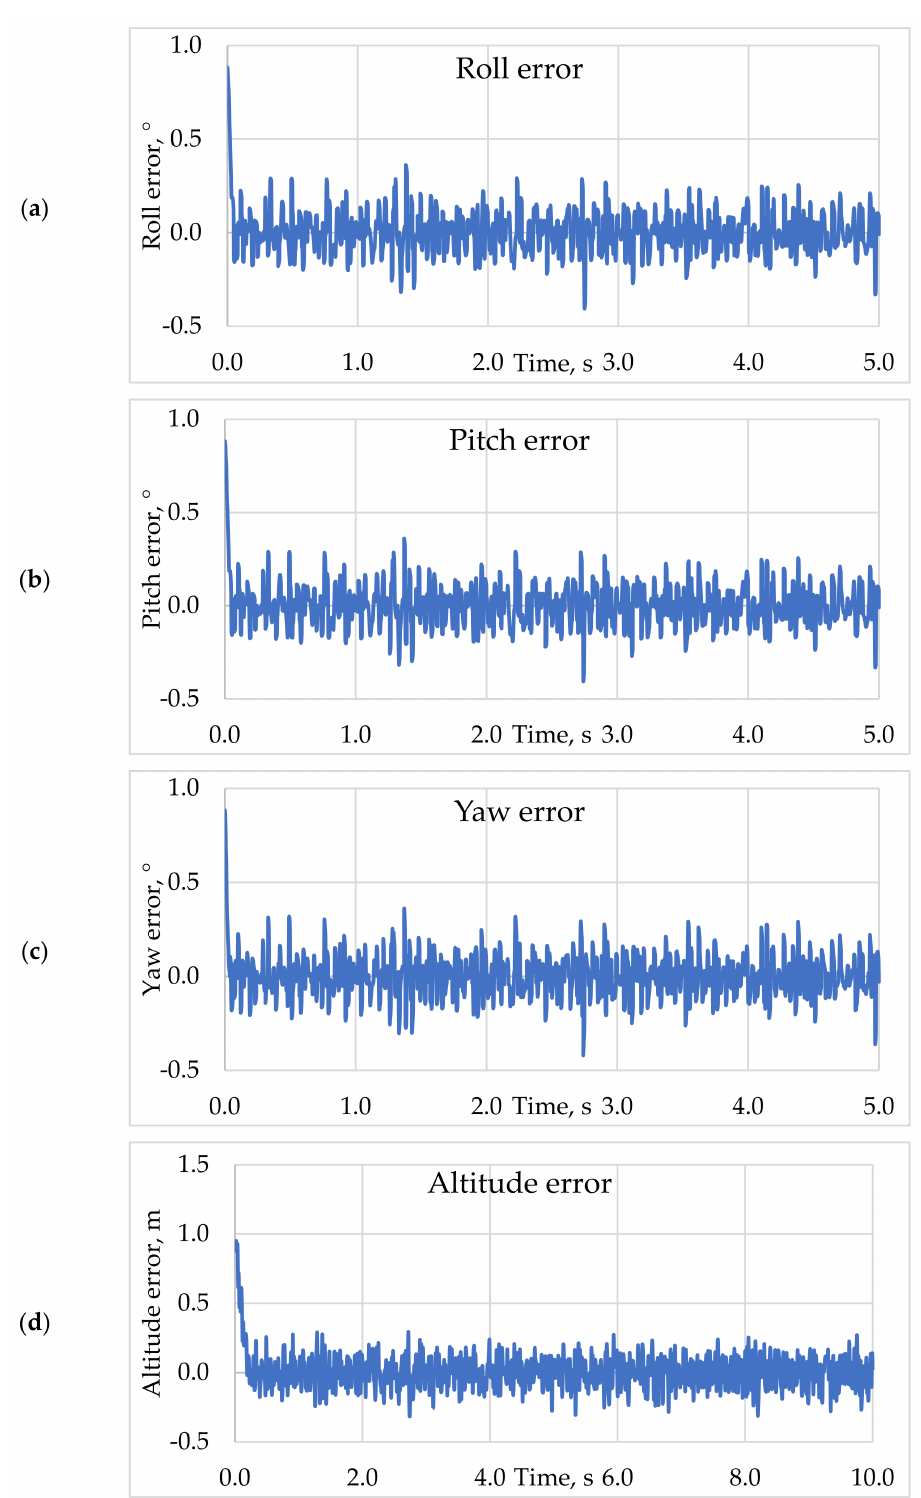
Figure 10. The response of the altitude and attitude error of the system, ( a ) roll, ( b ) pitch, ( c ) yaw, and ( d ) altitude